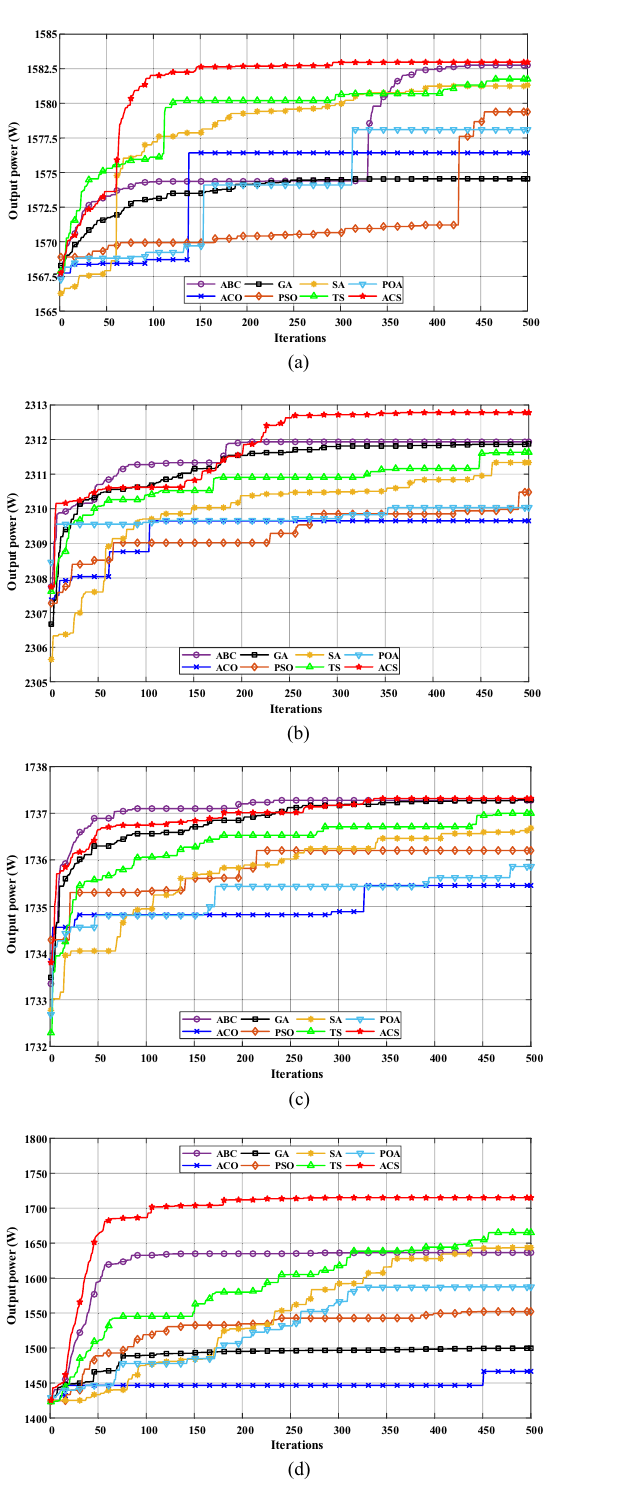
Fig. 8 Convergence curves of eight algorithms under four different scenarios of (15 15) TEG system: a diagonal, b outer, c inner, and d × random